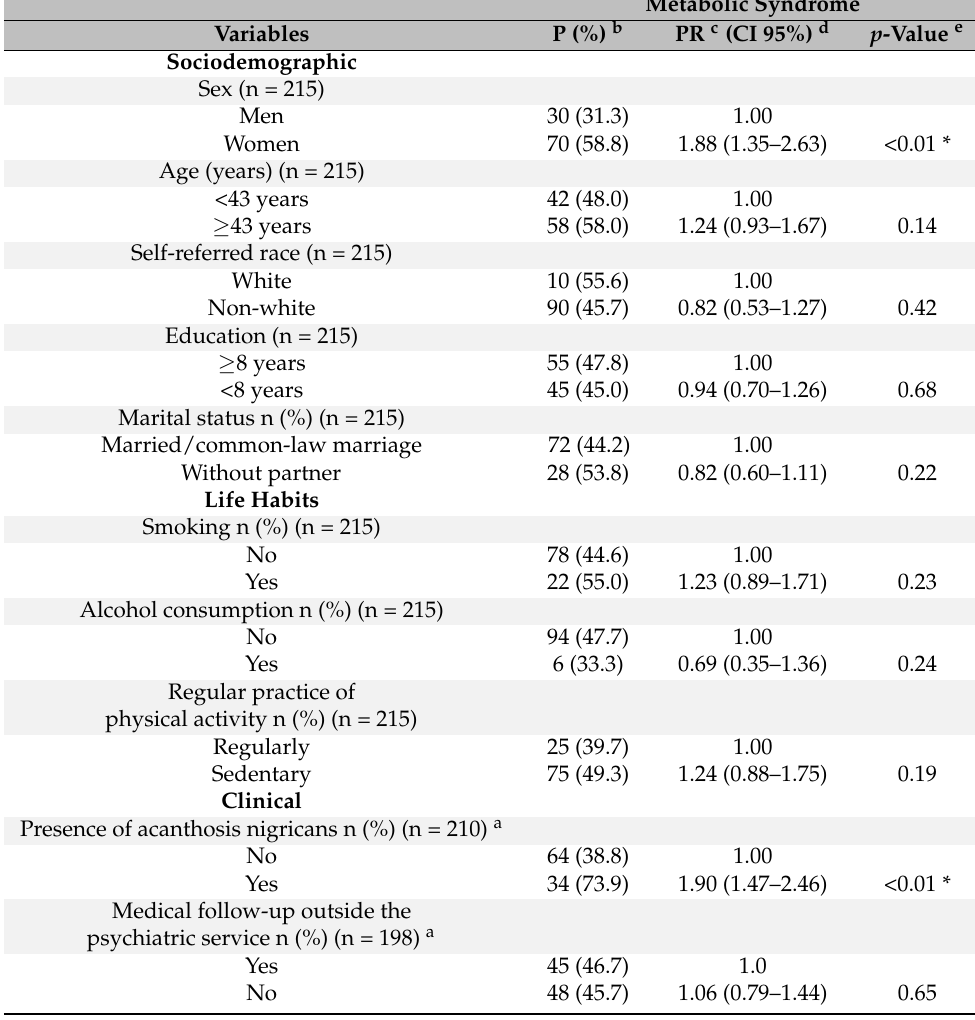
Table 3. Gross prevalence ratio of metabolic syndrome and its 95% confidence intervals according to sociodemographic and clinical variables in the users of a Psychosocial Care Center, Bahia, Brazil, 2019 (n =